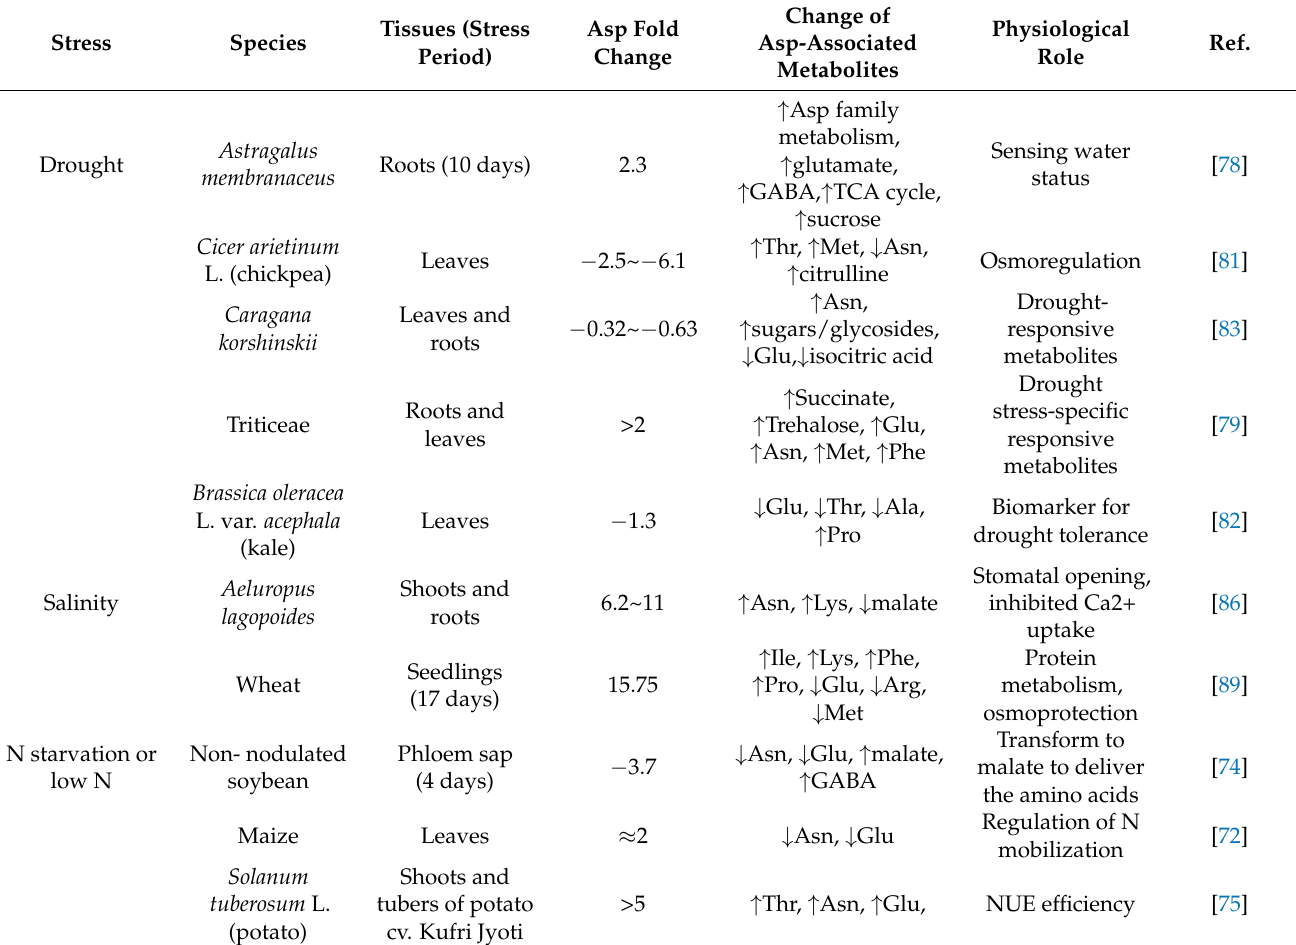
Table 1. Induction and repression of Asp in different plant species under various stress conditions.